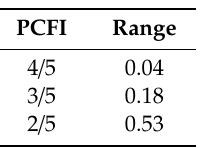
Figure 6. The 2 / 5 PCFI result. Figure 6. The 2/5 PCFI result. Table 3. Ranges of various PCFI